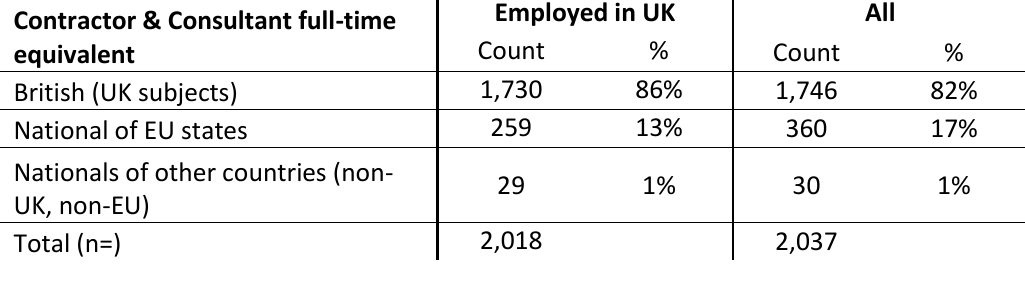
Table 3: Staff nationalities